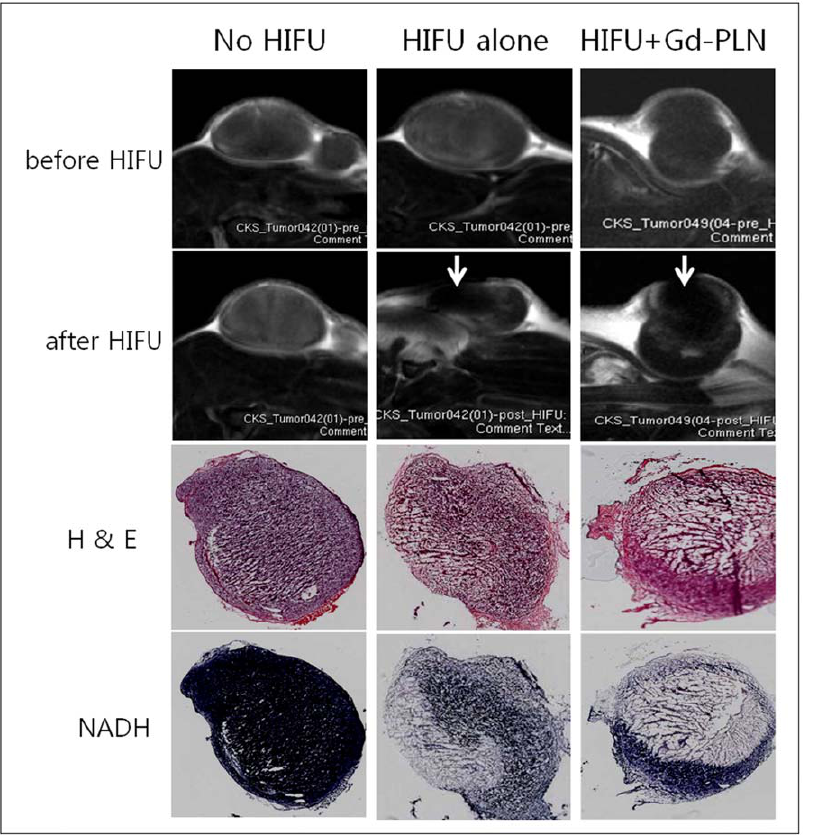
Figure 6. The effect of the Gd-C 5 F 12 -PLN-100 on HIFU tumor ablation in the subcutaneous tumor model. The tumor ablation by HIFU was monitored by gadolinium -enhanced T1-weighted imaging before and after HIFU treatment. The contrast-enhanced images were subtracted from the image before enhancement. The arrow indicates the HIFU orientation (upper panel). The HIFU ablation was also examined by H&E and NADH staining of frozen specimens to confirm the ablated area (lower panel).